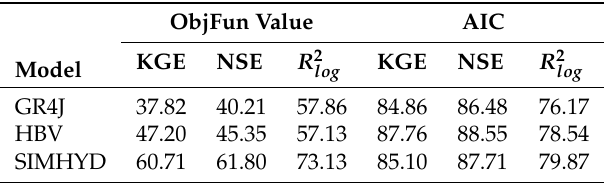
Table 4. The percent amount of variance explained by the Random Forest models when predicting the objective function and Akaike Information Criterion